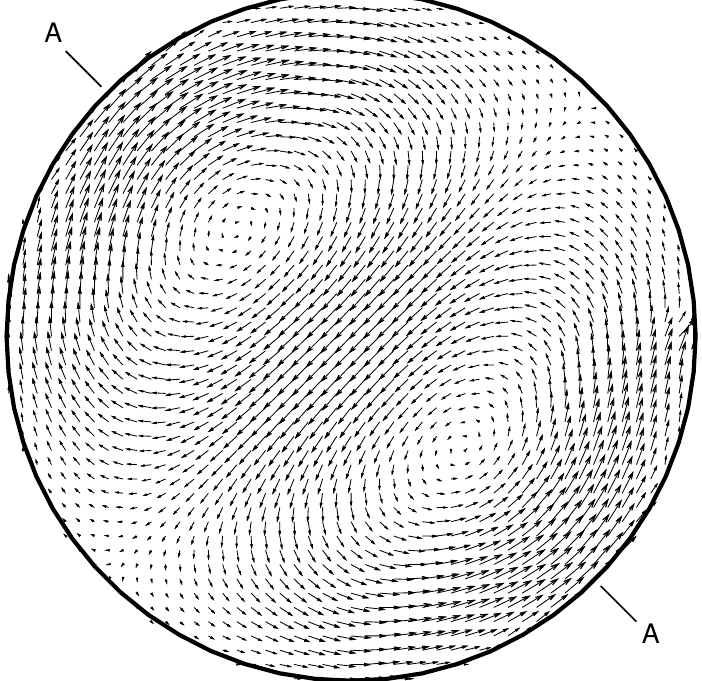
Figure 4. Flow field for wind-driven flow, showing well-developed counter-rotating gyres with flow in the deeper water against the direction of the wind.